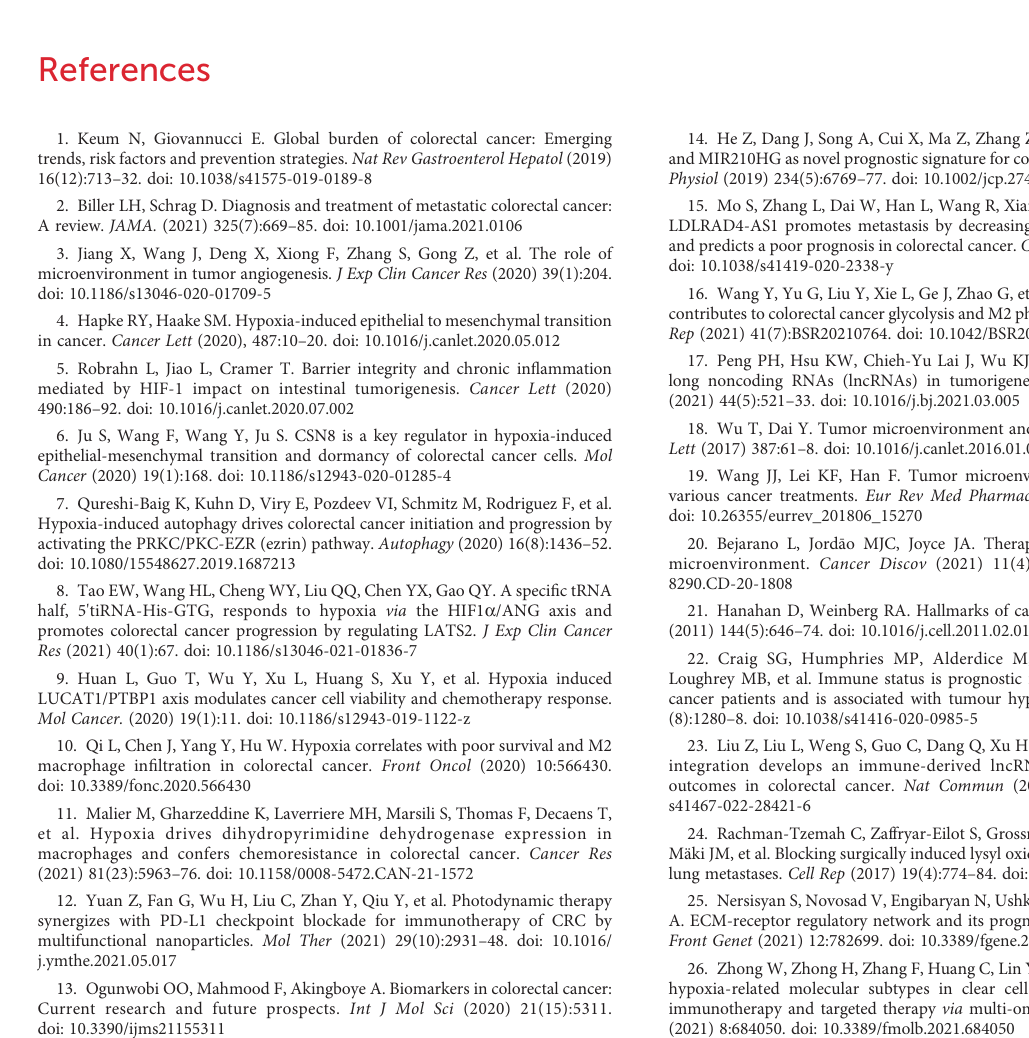
SUPPLEMENTARY FIGURE 5 Therapeutic response prediction of 33 drugs between the high- and low- risk